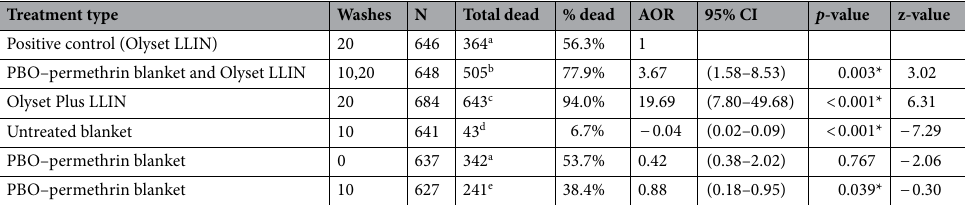
Table 1. The overall percentage mortality of Anopheles gambiae Muleba-Kisumu in the experimental huts. N is total mosquito released; AOR is adjusted odds ratio for random effects; CI is confidence interval. * Statistically significant. Values along a row bearing the same letter label are not significantly different ( p >